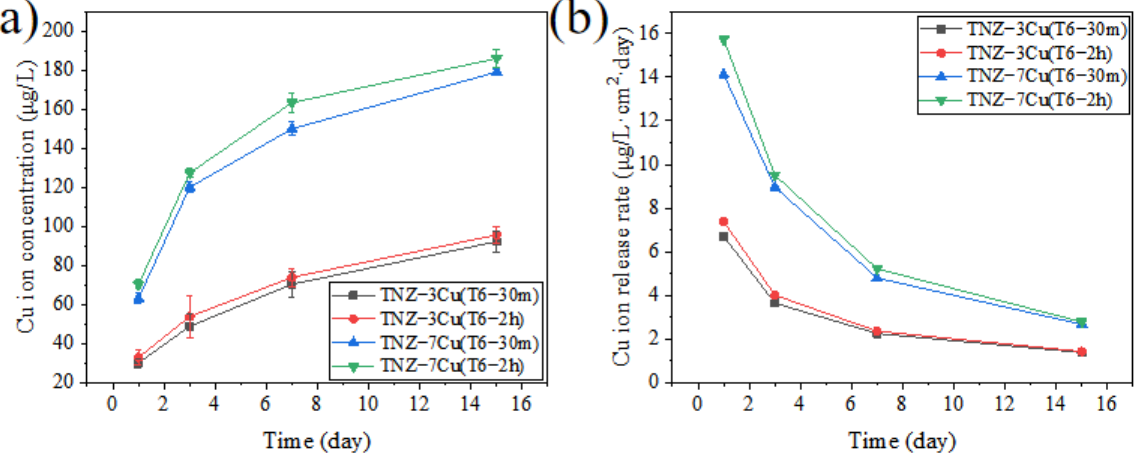
Figure 9. Cu ion accumulative release concentration and release rate from different TNZ-xCu(T6) alloys: ( a ) Cu ion release concentration, ( b ) Cu ion release rate.